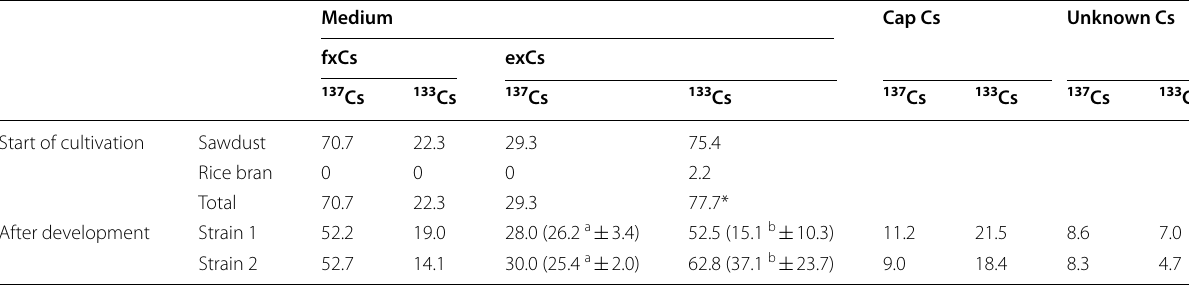
The fixed Cs (fxCs) amount and exchangeable Cs (exCs) solubilization ratio were referred to Eqs. 4 and 5. The numbers in parentheses indicated the exCs solubilization ratio and its standard deviation. *Total value did not match due to the rounding of values. The same letters indicated the comparison groups and there was no significant difference between them according to t